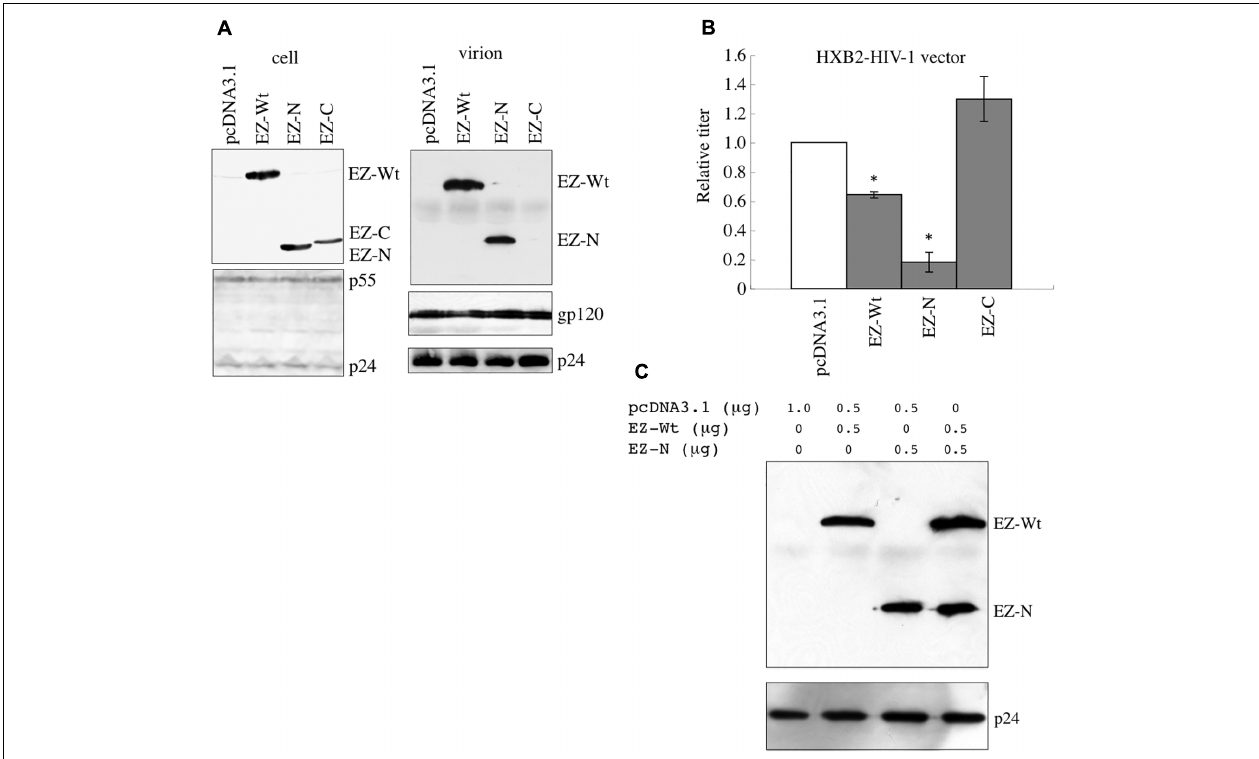
FIGURE 2 | Incorporation of EZ-N into HIV-1 vector particles reduces their infectivity. (A) COS7 cells were transfected with the HIV-1 vector construction plasmids together with the pcDNA3.1, EZ-Wt, EZ-N, or EZ-C expression plasmid. Cell lysates (left panel) and virion-containing pellets of culture supernatants from the transfected cells (right panel) were analyzed by western immunoblotting using the anti-VSV-G epitope (upper panel) or anti-HIV-1 p24 (lower panel) antibody. ( B ) Culture supernatants from the transfected cells were inoculated into HeLa/CD4 cells, and transduction titers were measured. Transduction titers of pcDNA3.1-transfected cells were always set to 1, and relative values of transduction titers of other cells are indicated. Error bars show standard deviations, and asterisks indicate statistically significant differences compared to the pcDNA3.1-transfected cells. ( C ) COS7 cells were transfected with the HIV-1 vector construction plasmids together with EZ-Wt and/or EZ-N. Virion pellets from the transfected cells were analyzed by western immunoblotting using the anti-VSV-G epitope or anti-p24 antibody.